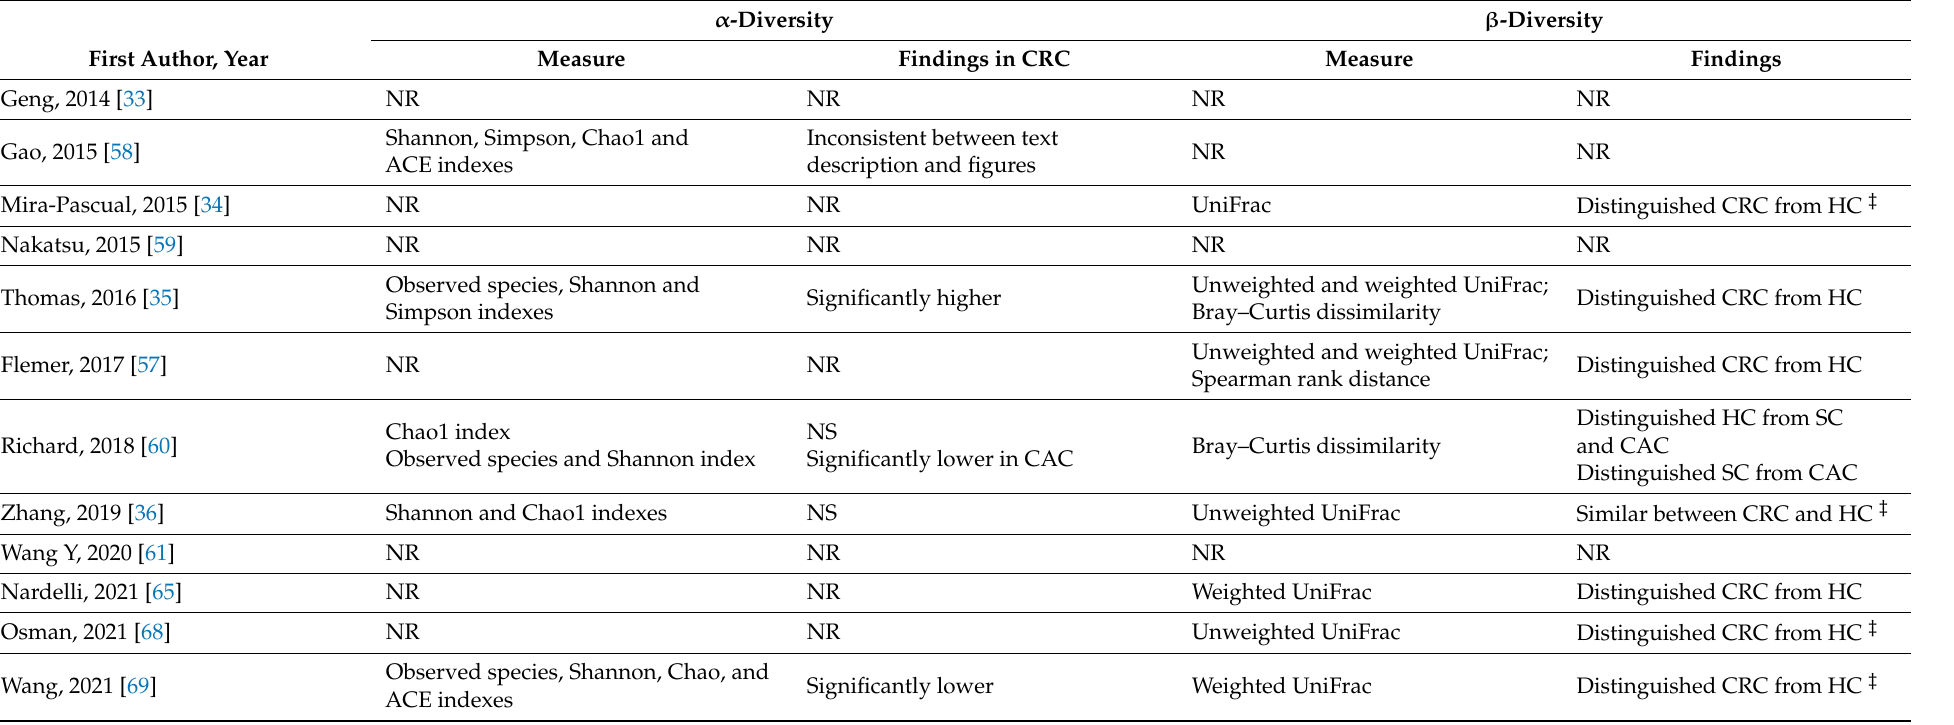
Table 3. Summary of the diversity findings in the colorectal microbiota of CRC patients and healthy controls. α -Diversity β -Diversity